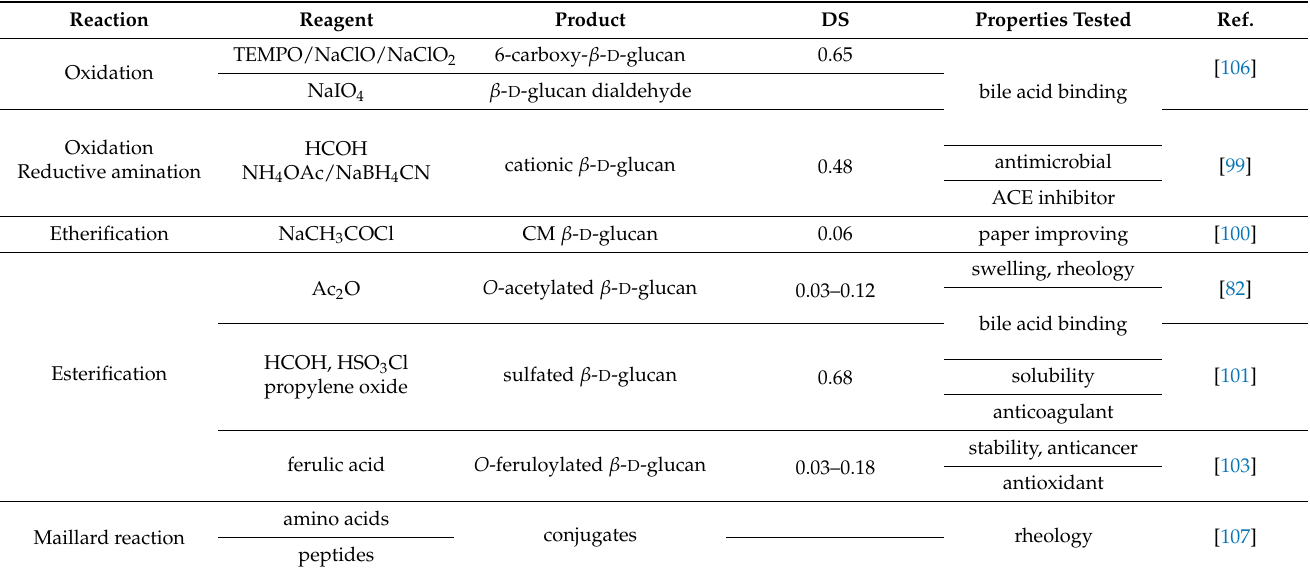
Table 3. Chemical modification of oat β - D